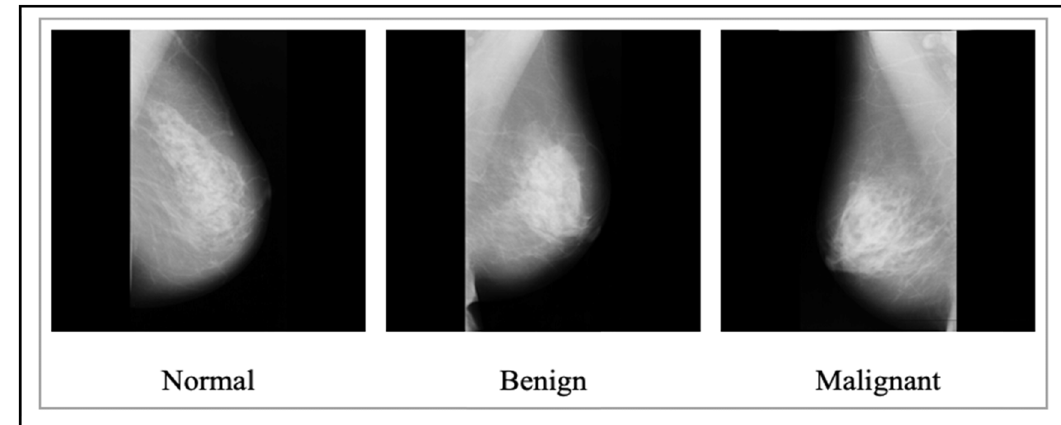
Figure 9: Mammography images from the MIAS dataset [ 113 ]